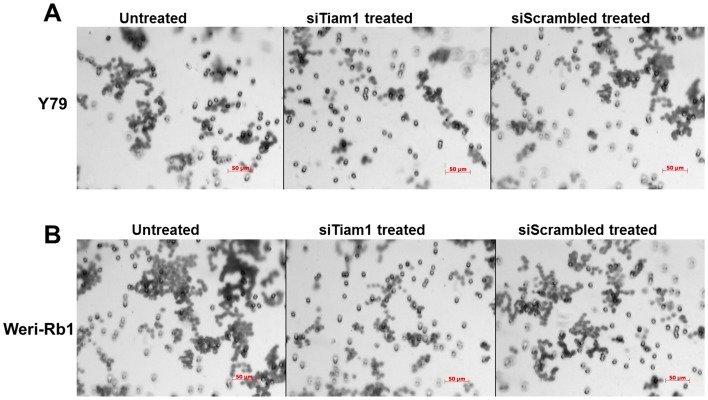
Matrigel invasion assay of Tiam1 deficient RB cell lines.
A. Y79 panel showing the invasion of untransfected, siTiam1 treated and scrambled siRNA treated cells. B. Weri-Rb1 cells. The matrigel invasion chambers post invasion was stained with crystal violet and images acquired at 20× objective. The experimental results were representative of triplicate result repeated twice.